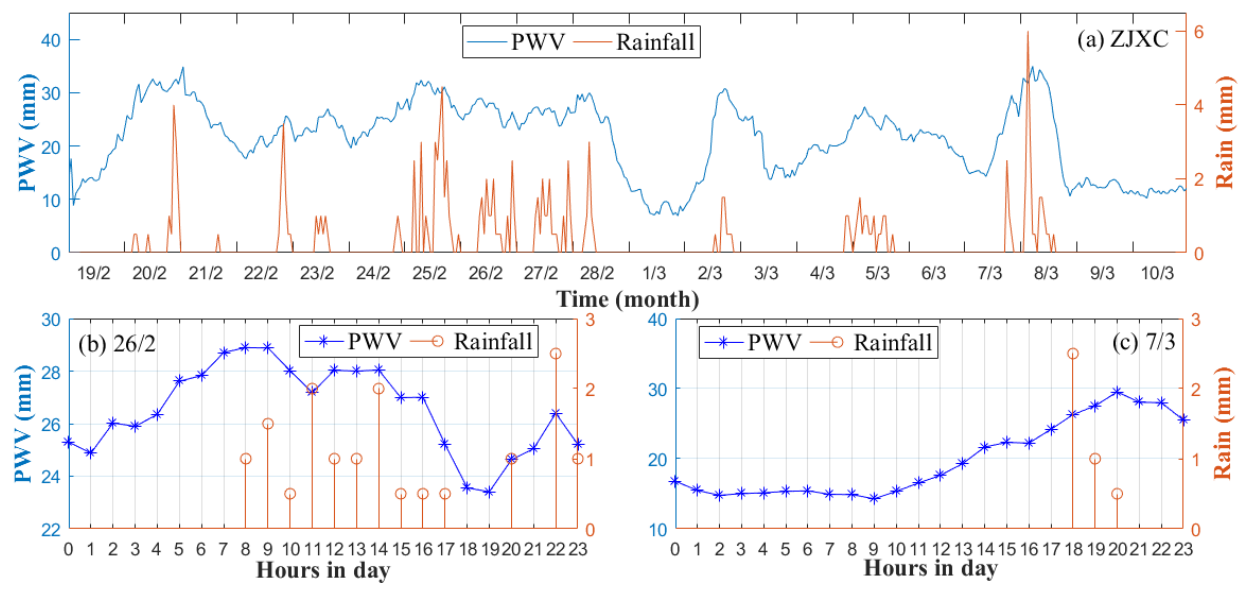
Figure 11. Relationship between hourly PWV and rainfall at ZJXC station over the period from 19 February to 10 March 2015, where ( a ) refers the time series of PWV and rainfall over the period of 19 February to 10 March 2015, ( b ) and ( c ) are the hourly PWV and rainfall on 26 February and 7 March, respectively.